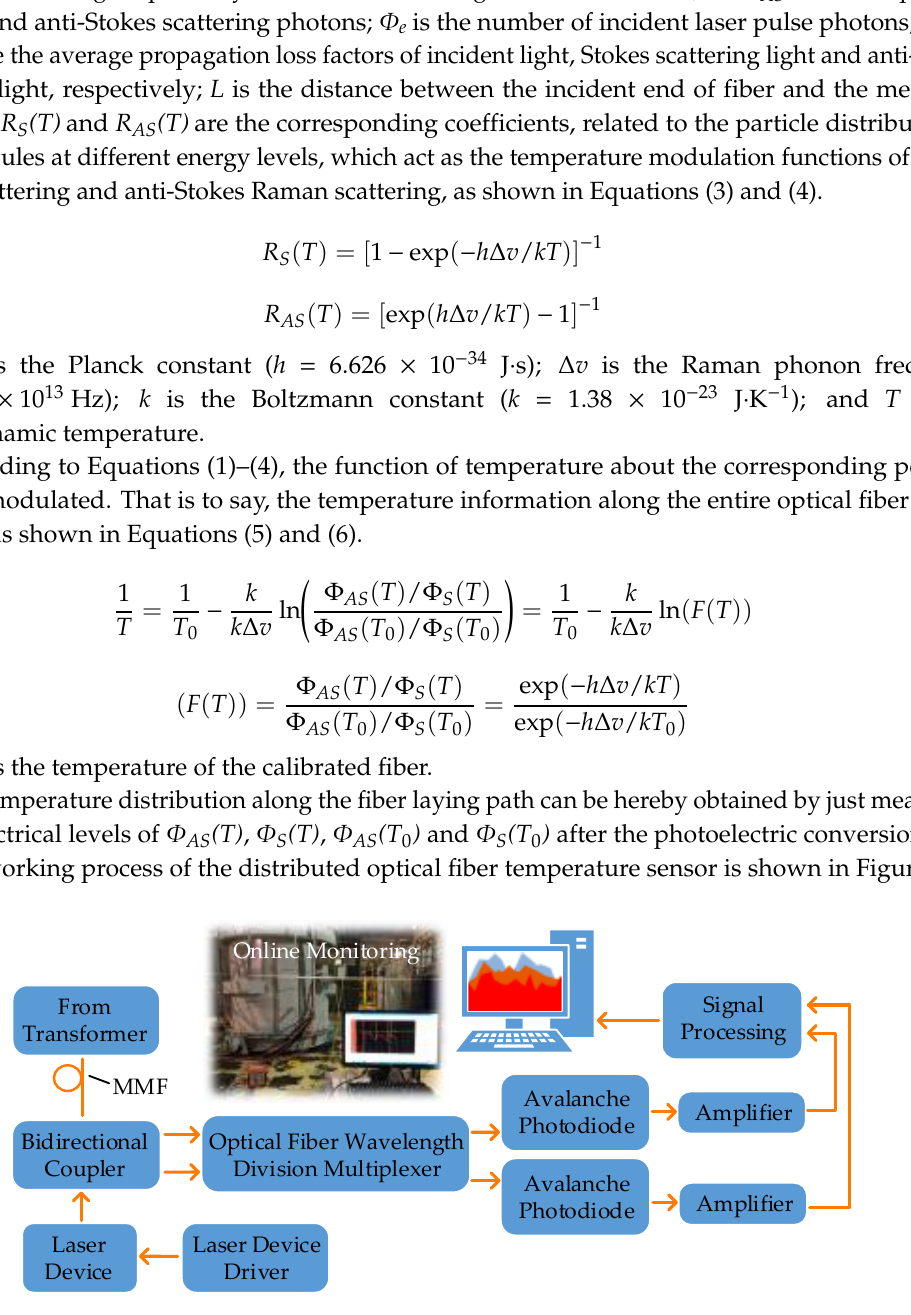
Figure 1. Principle of transformer temperature on-line monitoring based on DFOS.